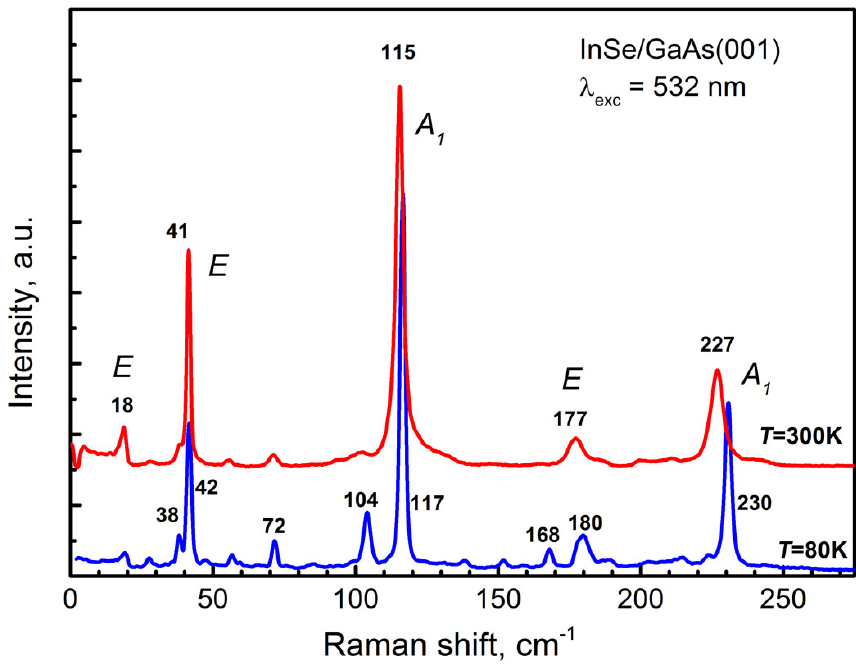
Figure 10. The Raman spectra of the InSe / GaAs(001) layer (sample # IS1 ) measured at 300 K (red curve) and at 80 K (blue curve). The symmetrycep of the phonon modes are given in accordance with [87].